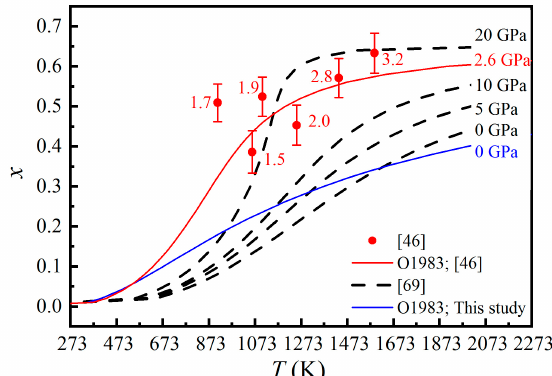
Figure 8. Correlations between temperatures ( T ), pressure ( P ) and x of the MgAl 2 O 4 -spinel. Red points stand for the equilibrium experiment data for the Mg-Al cation exchange reaction acquired by Méducin et al. [46], which passed our evaluation. Numbers beside them are pressures in GPa for the experiments. Red solid line refers to the O’Neill and Navrotsky thermodynamic model [50] calibrated for a pressure of 2.6 GPa by Méducin et al. [46]. Black dashed lines stand for the thermodynamic models at different P theoretically obtained by Da Rocha and Thibaudeau [69]. Blue line refers to the O’Neill and Navrotsky thermodynamic model [50] calibrated by our x - T data. In conclusion, the effect of pressure on the Mg-Al cation exchange reaction is presently unclear.